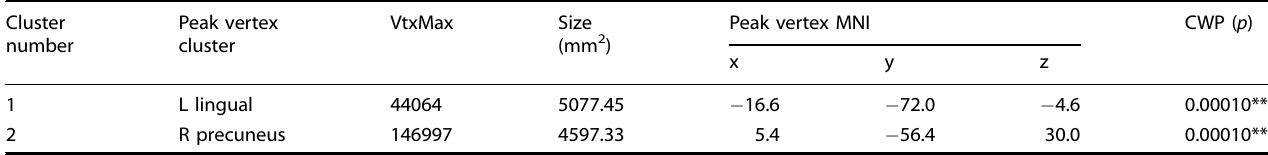
Table 3. Description of clusters with signi fi cantly reduced local gyri fi cation index (lGI) in the unaffected relatives (URs) compared to the healthy controls (HCs) in the left and right hemispheres after clusterwise correction for multiple comparisons using Monte Carlo simulation ( p <